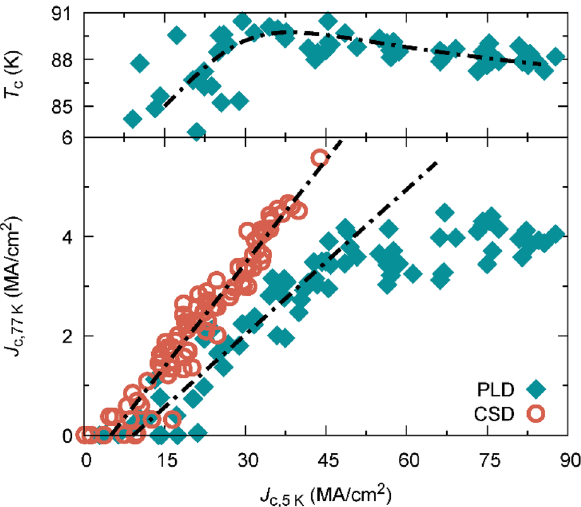
Figure 7. Superconducting physical properties correlations for PLD and CSD films. T c dependence with self- field inductive J c ( 5K ) (upper panel) showing the intrinsic relation of both quantities with the charge carrier density. Self-field J c ( 77K ) as a function of self-field J c ( 5K ) for YBCO films obtained by PLD and CSD (lower panel). The different linear trends for J c ( 5K ) <50 MA/cm 2 reveal growth dependent pinning defect landscapes, with possibly higher strong-pinning contribution in CSD films. With increasing J c ( 5K ) in PLD films, J c ( 77K ) saturates, probably due to a reduced contribution of weak pinning at high temperatures and the proximity to the superconducting transition in the overdoped regime, as indicated in the upper panel by a decreased T c for high J c ( 5K ) films. All lines are guide to the eye.